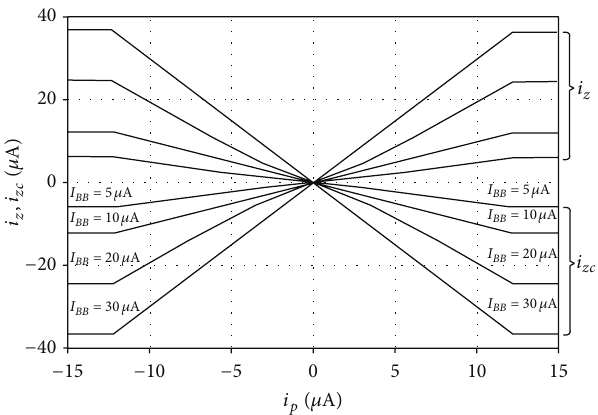
Figure 8: 𝑖 𝑧 , 𝑖 𝑧𝑐 −𝑖 𝑝 DC transfer characteristics of the proposed CG- CFTA for different values of 𝐼 𝐵𝐵 .